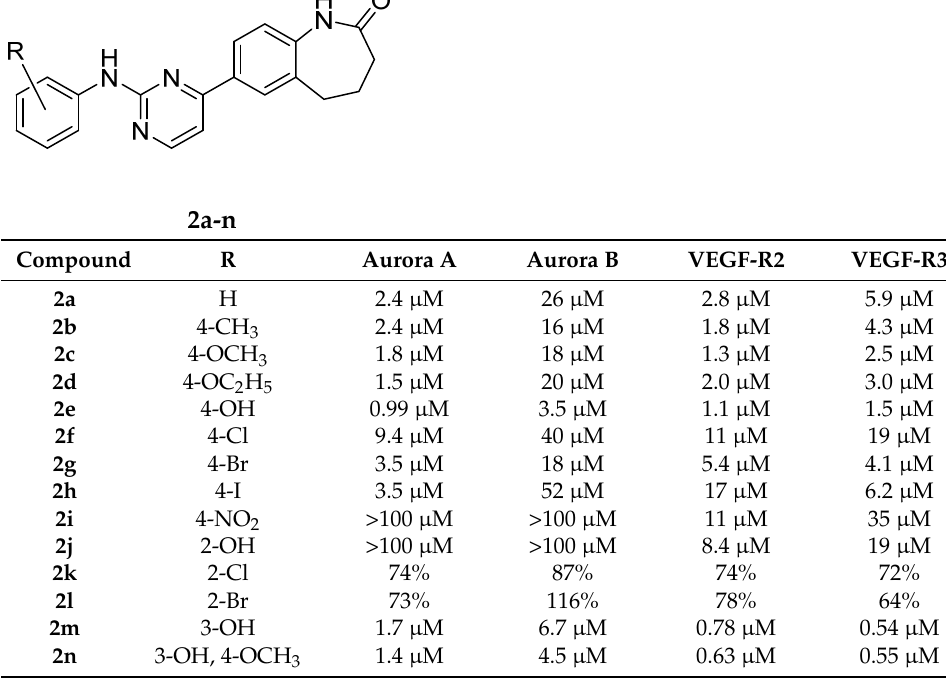
Table 3. Kinase inhibitory activity of 7-(2-anilinopyrimidin-4-yl)-1-benzazepin-2-ones 2a - 2n against Aurora A, Aurora B, VEGF-R2 and VEGF-R3, represented by either IC 50 value (µM) or residual activity at 10 µM (%). a.